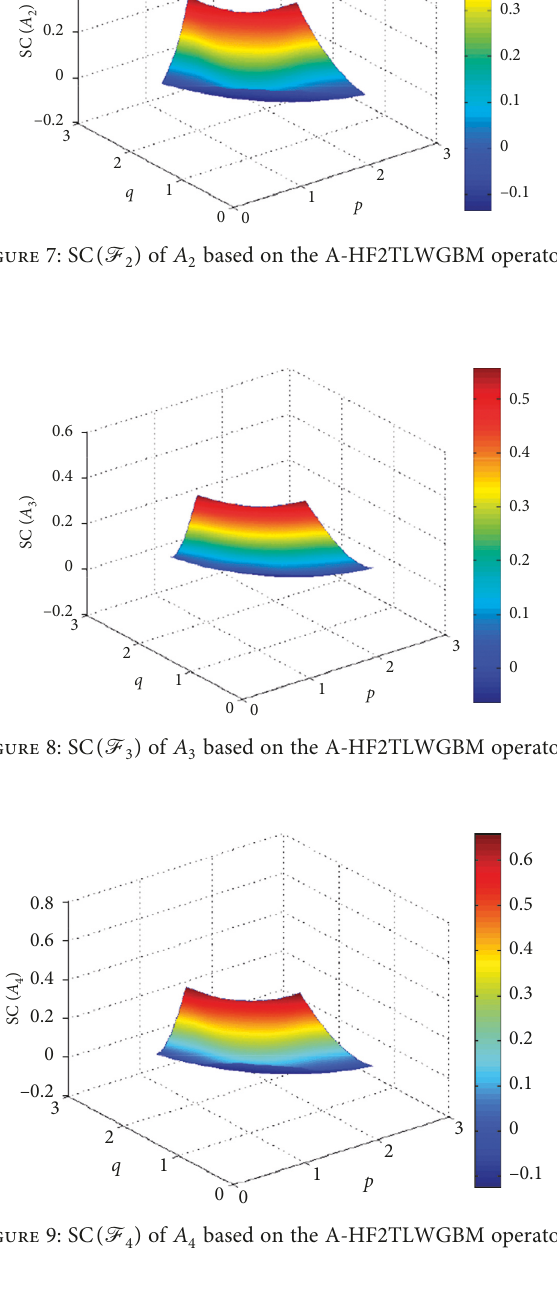
) of A based on the A-HF2TLWGBM operator. 4 4